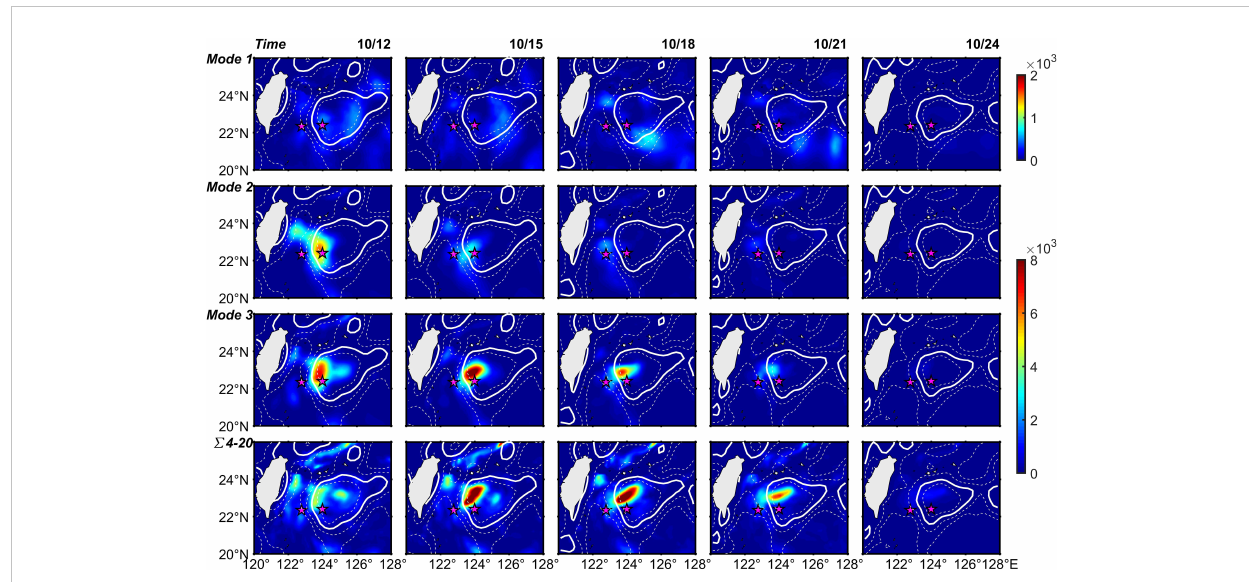
FIGURE 11 Time evolution of depth-integrated NIKE (unit: J/m 2 ) of different modes from 12 to 24 October. All other elements are the same as Figure